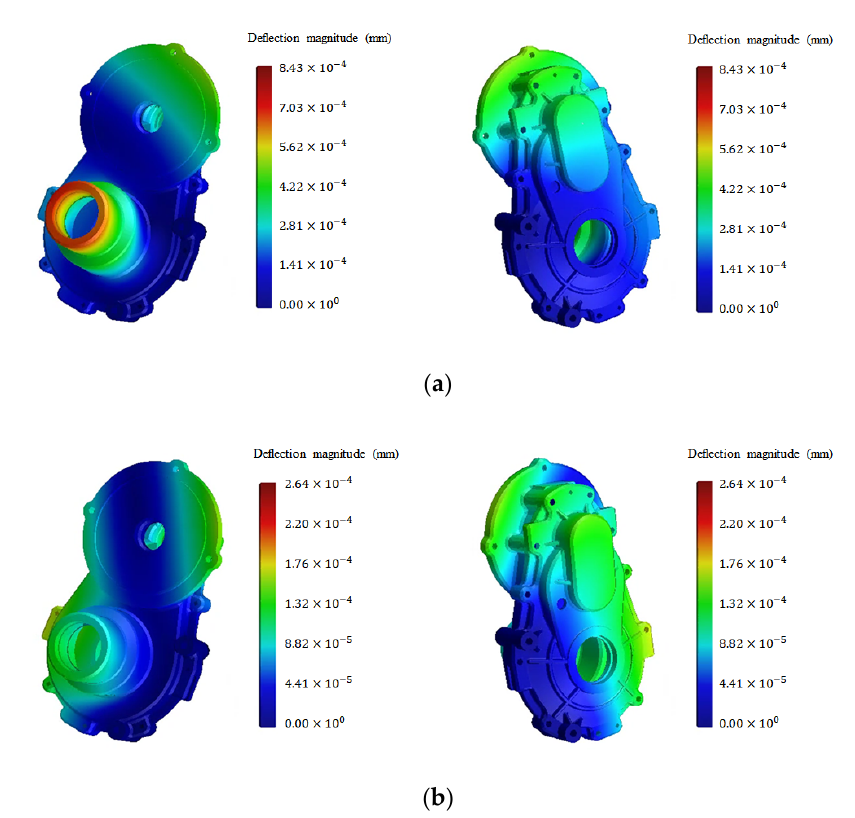
Figure 12. Operating deflection shape (ODS) for clockwise drive. ( a ): ODS excited by gear mesh stage 1-first harmonic at 3500 rpm; ( b ): ODS excited by gear mesh stage 1-second harmonic at 2636 rpm.